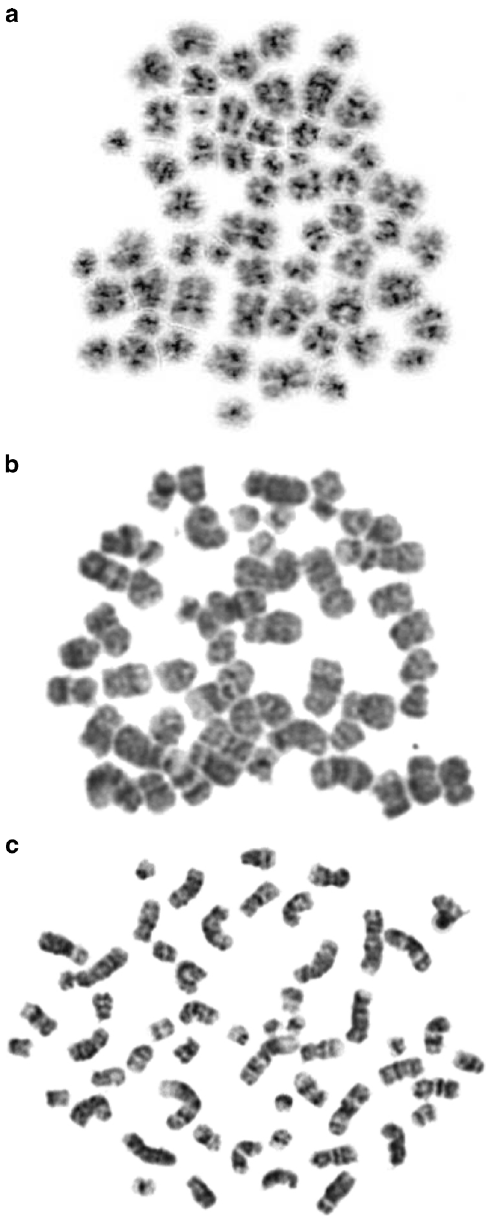
Fig. 7 Metaphase chromosome morphology in hyperdiploid leukemia. High hyperdiploid childhood acute lymphoblastic leukemia samples displayed varying metaphase chromosome morphology, but the majority of cases had poor morphology. a Example of metaphase with score 1 — poor morphology